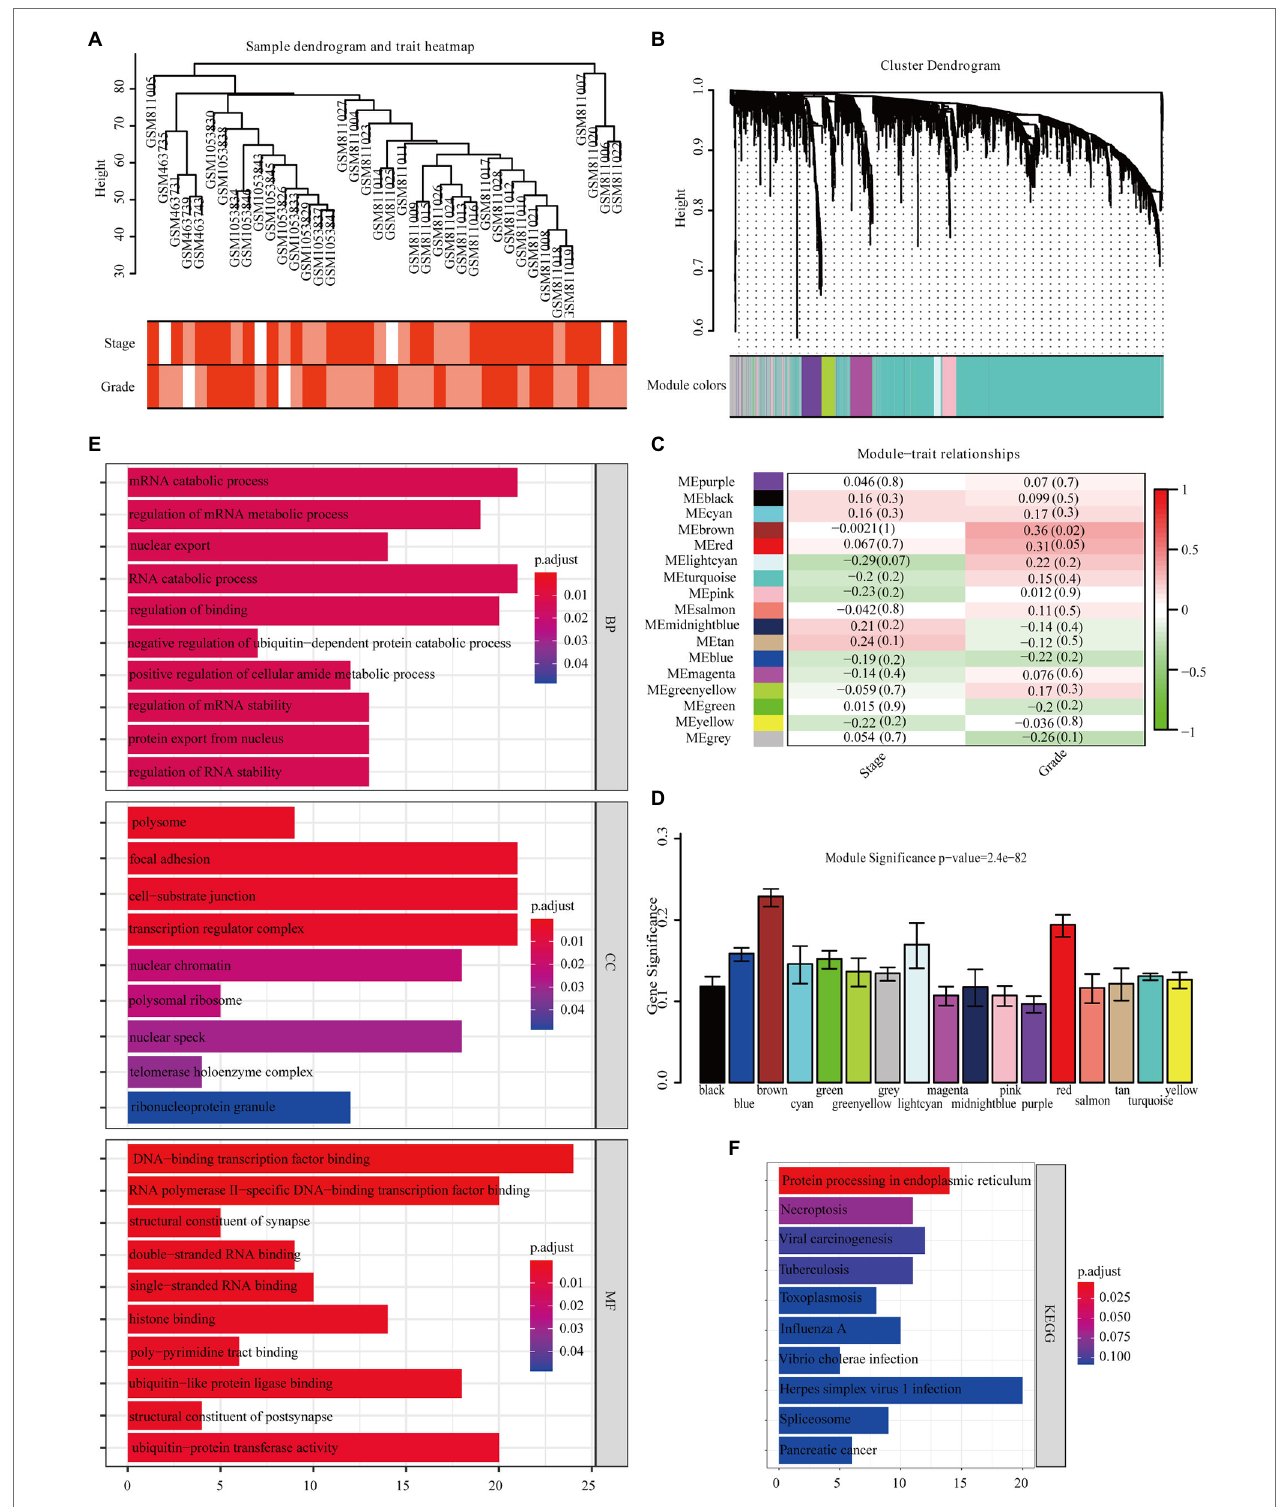
FIGURE 2 | Identification of modules closely related to the clinical characteristics of pancreatic adenocarcinoma (PAAD). (A) Clustering dendrogram of 40 samples. (B) Dendrogram of all differentially expressed genes clustered based on a dissimilarity measure (1-TOM). (C) Correlation heatmap between module eigengenes (MEs) and the clinical characteristics of PAAD. (D) Distribution of average gene significance (GS) in 17 modules significantly related to PAAD grade. Functional enrichment analysis of all genes in the brown module [ (E) Gene ontology, (F) Kyoto Encyclopedia of Genes and Genomes